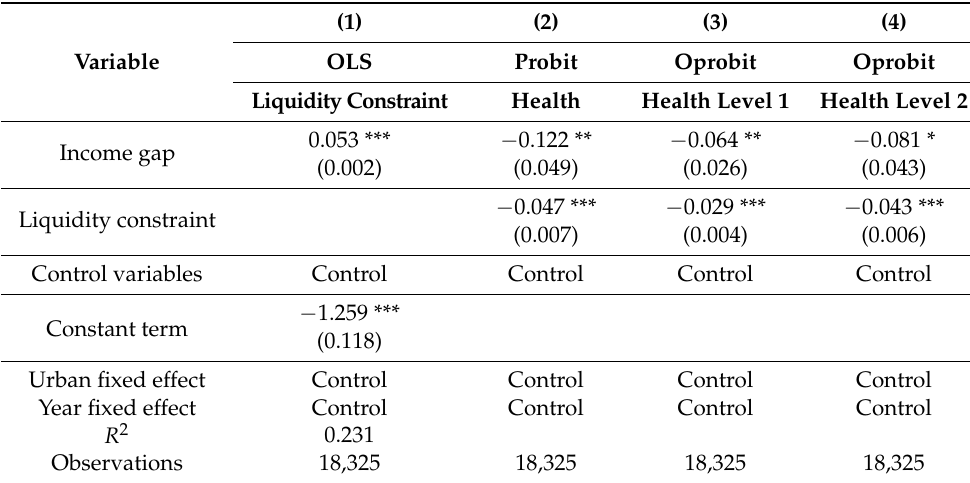
Table 10. Income gap, mobility constraints, and health of rural